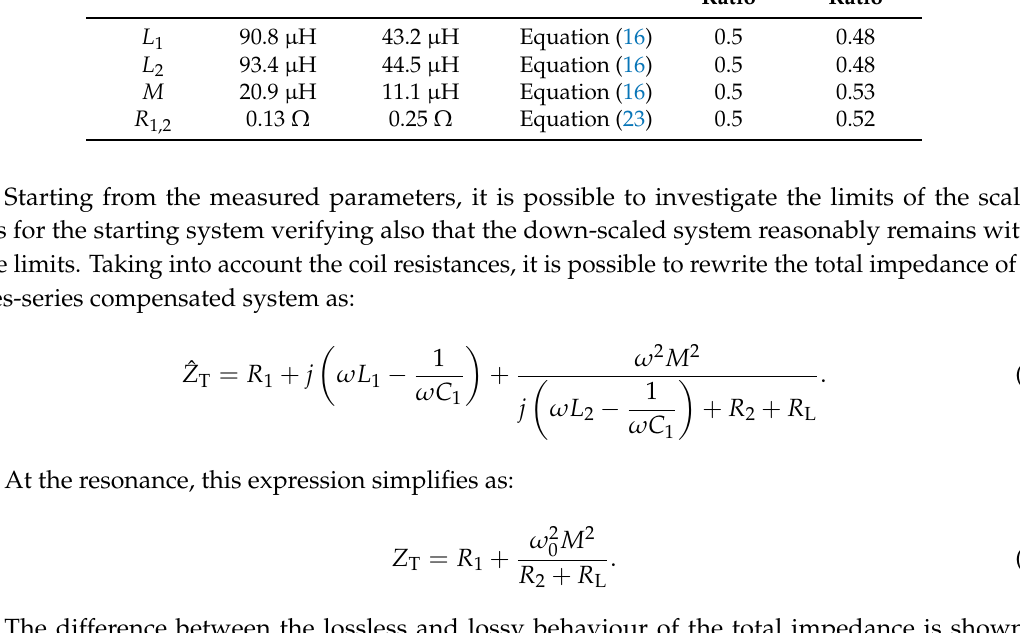
Table 3. Measured resistances, self and mutual inductances of starting and scaled IPT systems. Original Down-Scaled Reference Parameter System System Rule